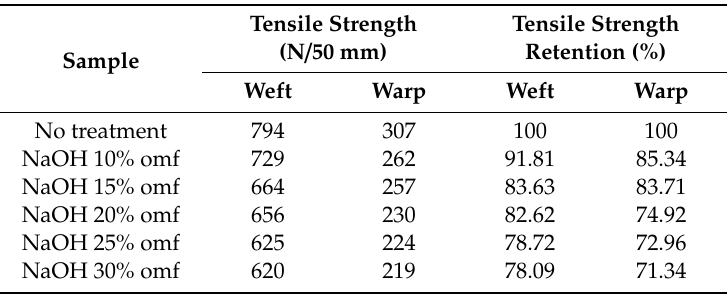
Table 1. Tensile strength retention of sea ‐ island ‐ type ultramicrofiber tricot fabrics treated with various NaOH concentrations at 100 °C.